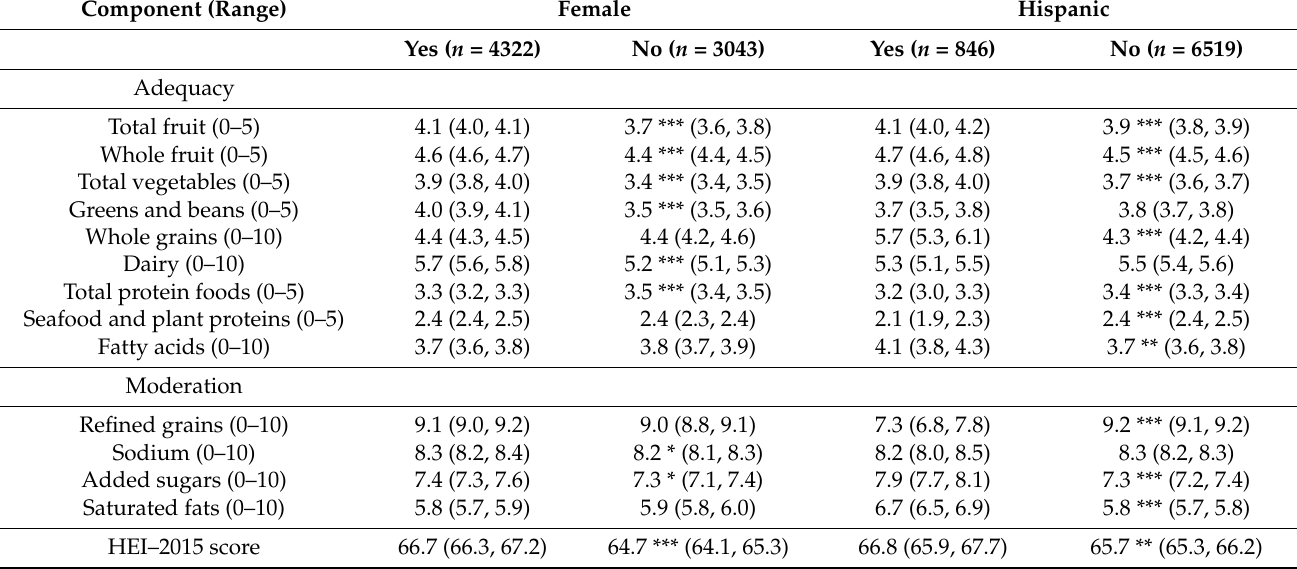
Table A1. Healthy Eating Index–2015 (HEI-2015) and component